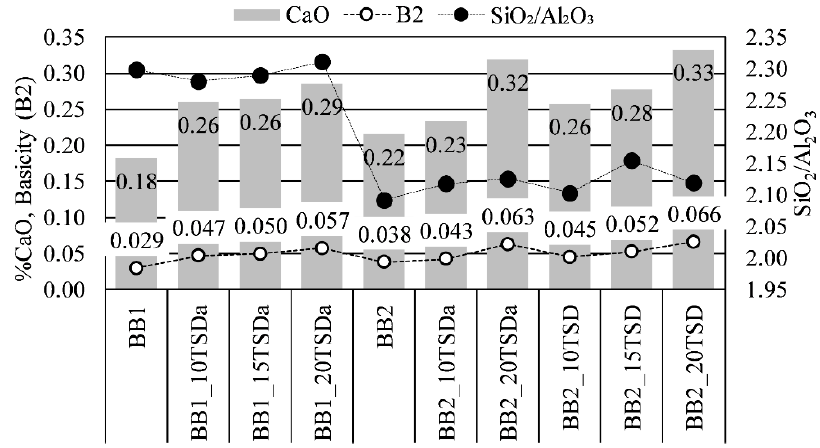
Figure 6. CaO, basicity B2 and ratio of SiO 2 /Al 2 O 3 for laboratory-produced coke.